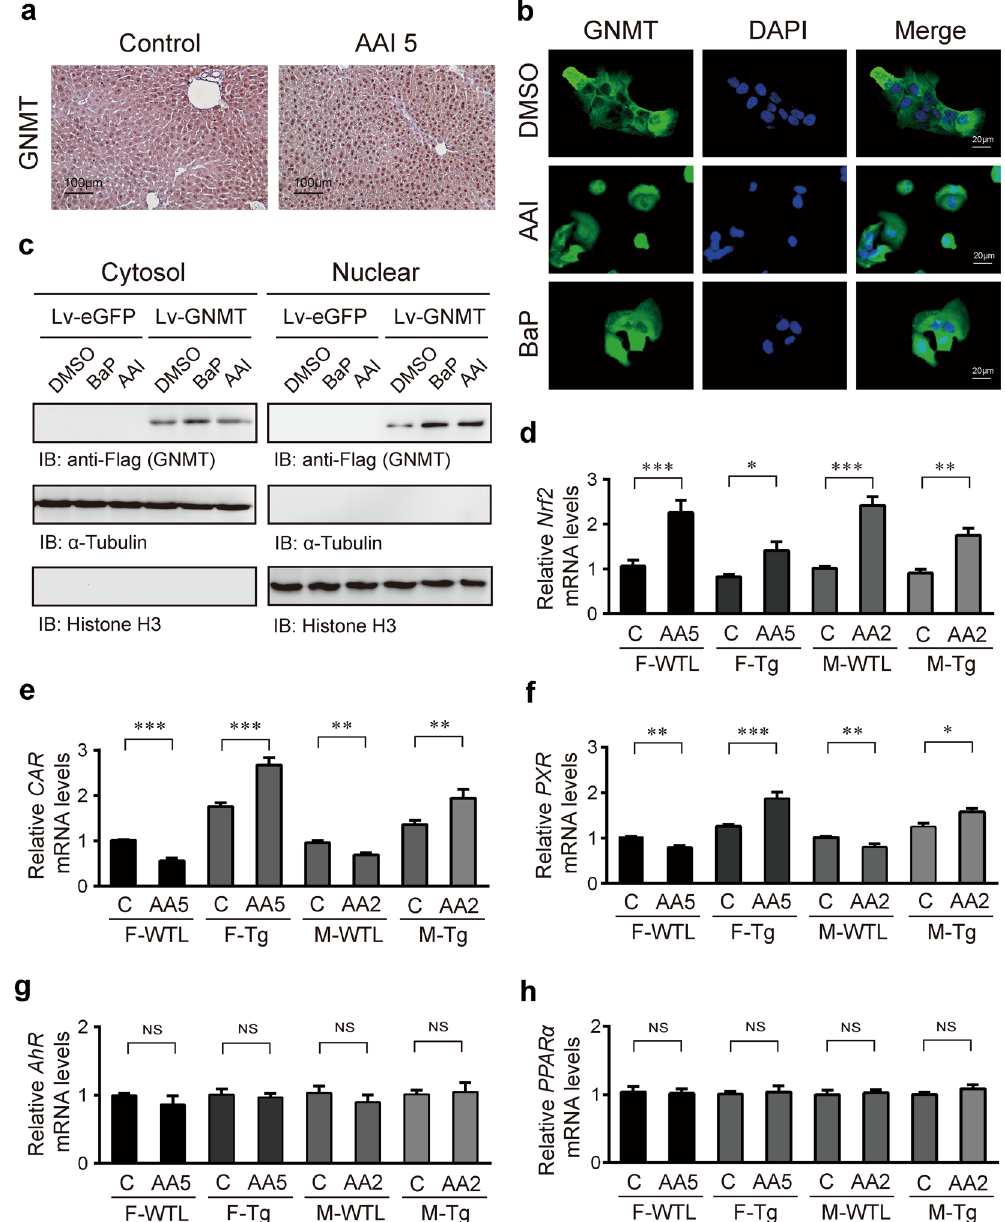
Figure 6. AAI promotes the nuclear localization of GNMT in the liver. ( a ) Immunohistochemical staining for GNMT expression in the liver of the female C57BL/6 mouse intraperitoneally injected with 5 mg/kg bw/day AAI (AAI 5) or corn oil (vehicle control) for 3 weeks (original magnification × 200). ( b ) Immunofluorescent microscopy of fixed Huh7 Lv-GNMT cells stained for GNMT (green, Alexa 488) and DAPI. Huh7 Lv-GNMT cells were treated with 250 μ M AAI, 10 μ M BaP (positive control) or vehicle (0.01% DMSO, negative vehicle control) for 16 hours (original magnification, × 200). ( c ) Western blot analysis of nuclear and cytoplasmic (non- nuclear) fractions from AAI-, BaP- and DMSO-treated Huh7 Lv-GNMT cells. Histone H3 and α -tubulin were used as loading and purity controls for the nuclear and cytoplasmic fractions, respectively. The full-length blots are presented in Supplementary Fig. S7. ( d–h ) mRNA levels of ( d ) Nrf2 , ( e ) CAR , ( f ) PXR (g) AhR , (h) PPAR α in the liver from AAI- or corn oil-treated hGNMT Tg mice, as described in Fig. 2a and b, were determined by qPCR. (C: mice treated with corn oil; AA2 orAA5: 2 or 5 mg/kg BW/day AAI administration; F: female; M: male; Tg: hGNMT transgenic mice; WTL: wild-type littermates of Tg mice) All qPCR data were normalized to β -actin. Values are presented as the mean ± SEM; n = 4 in each group. p -values were calculated using Student’s t -test. * p < 0.05, ** p < 0.001, *** p ≤